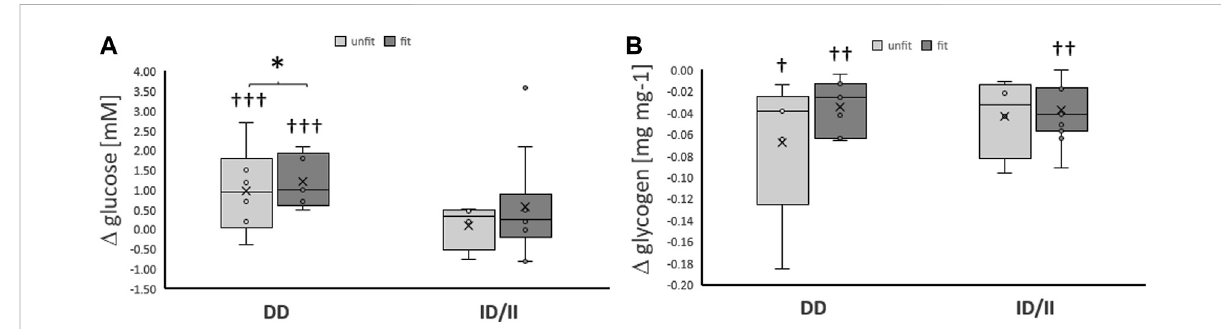
FIGURE 3 Exercise-inducedalterationsofglucosemetabolismrelatedcompoundspergenotypeand fi tnessstate. Box-Whiskerplotsofthedifferencesin theconcentrationofbloodglucose (A) andmuscleglycogen (B) immediatelyand½hour,respectively, afterone-leggedexerciseinassociationwith the ACE I-allele (i.e., genotype) and fi tness state. † , †† , ††† p < 0.05, < 0.01 < 0.001 for exercise-induced changes. *, p < 0.05 for differences between genotypes. Repeated measures ANOVA for the factor ACE-I/D genotype x exercise. N =